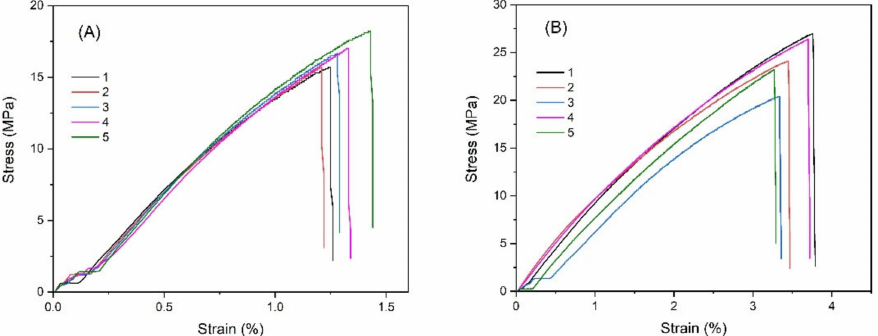
Figure 7. The stress-strain curves of ( A ) rPP30CBNW and ( B ) rPP30CBW composites. The number of each curve indicates the testing numbers.